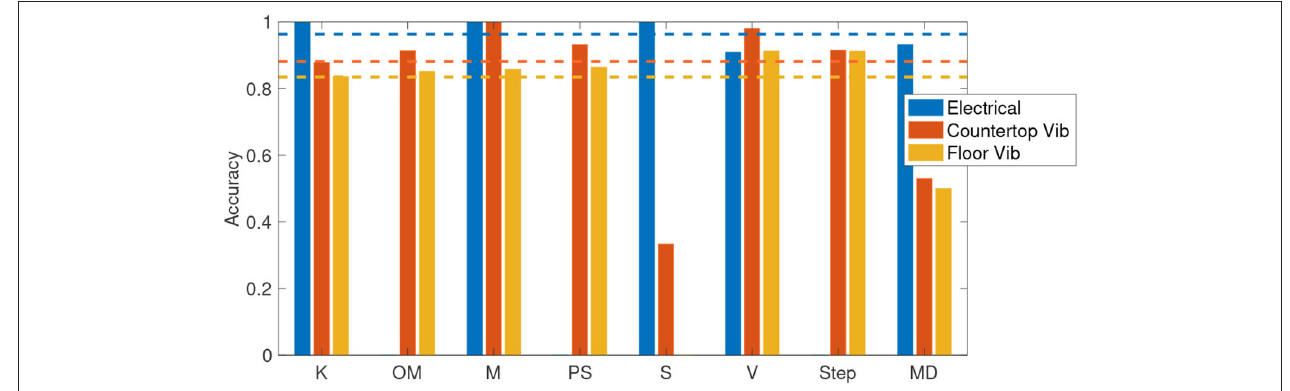
FIGURE 9 | Event-based classification